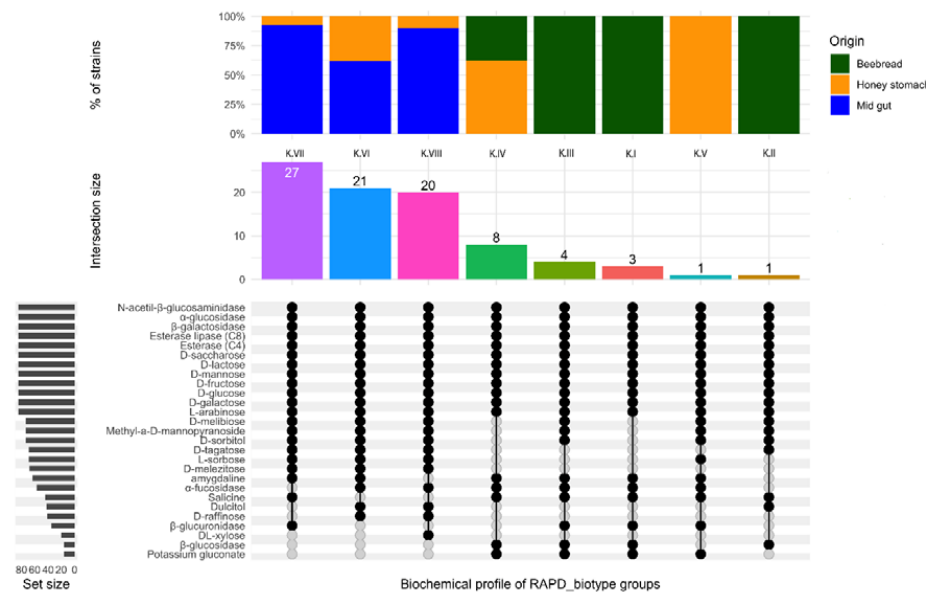
Figure 6. Upset plot regarding the biochemical profile of the 8 RAPD_biotype groups belonging to Apilactobacillis kunkeei . Vertical barplot indicates the number of overlapping strains (intersection size) for each intersection represented by the connected dots. The intersection matrix is sorted in descending order. The grey horizontal barplots, reported as “Set size”, indicate the number of strains showing enzymatic activity.